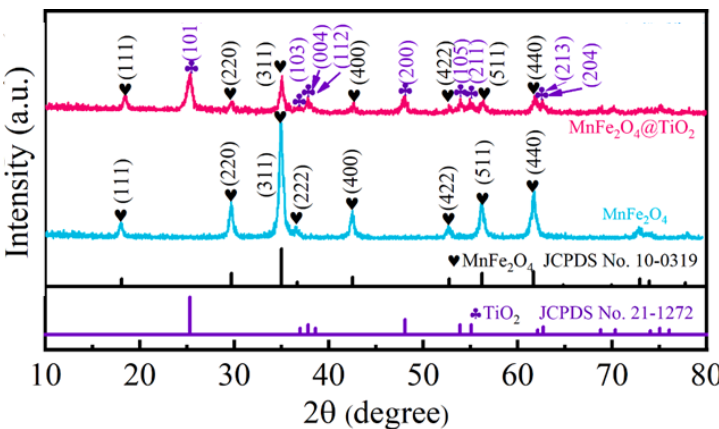
Figure 8. XRD patten of MnFe 2 O 4 and MnFe 2 O 4 /TiO 2 nanocomposites [106]. Republished with permission from Elsevier.